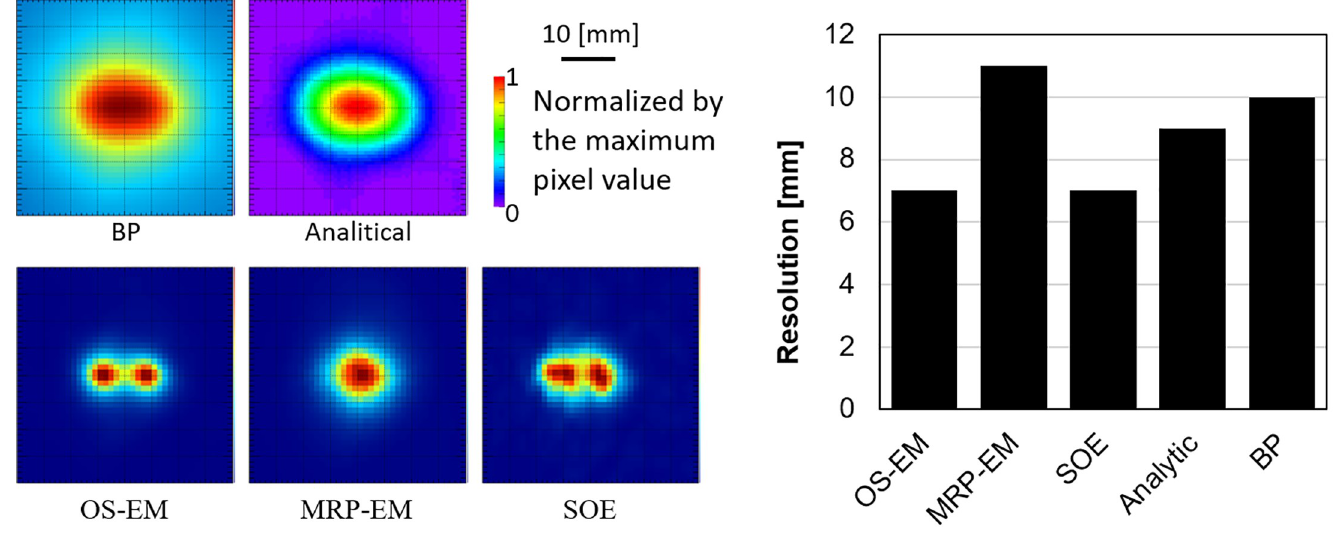
Fig 3. Images of two point sources with 8 mm distance (A)—(E) and spatial resolutions of the images reconstructed by the various algorithms (F).